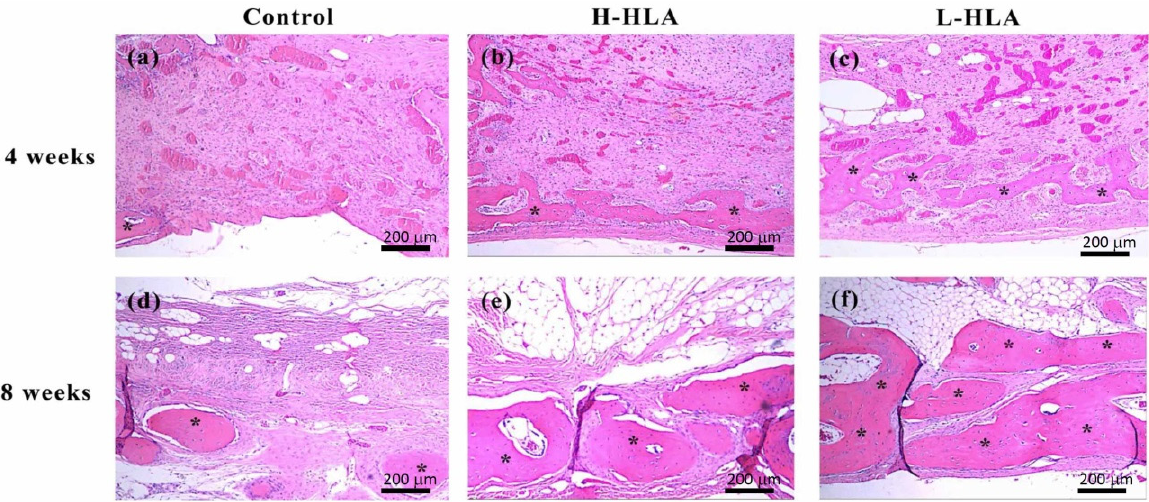
Figure 8. Histological images of bone tissue at artificial defects created in this study (magnification 200×). Microscopy shows HLA-free bone graft ( a , d ), bone graft mixed with H-HLA ( b , e ), and L-HLA-HA/ β -TCP ( c , f ) at 4 ( a – c ) and 8 weeks ( d – f ) post healing (* denotes newly formed bone). Scale bar = 200 µm.